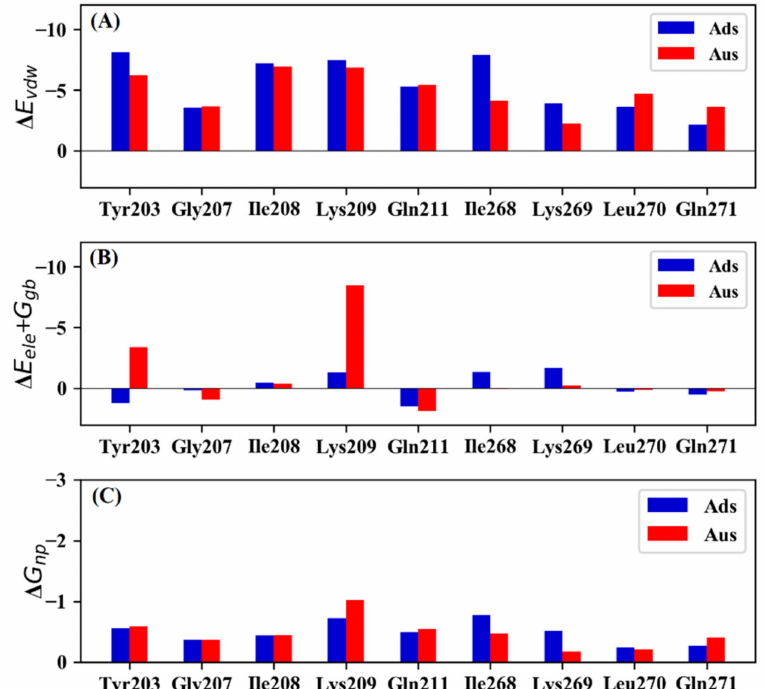
Figure 2. Detailed energy decomposition of Ads and Aus. ( A ) van der Waals (vdW). ( B ) sum of electrostatic and polar solvation energy. ( C ) non-polar solvation